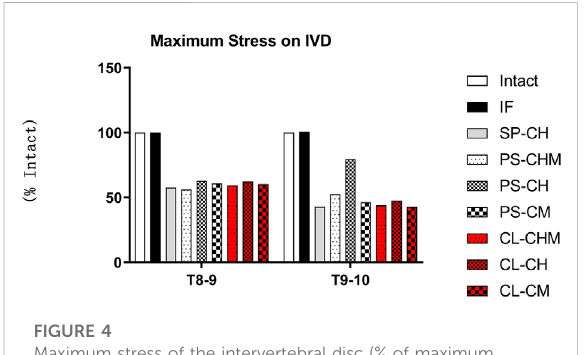
FIGURE 4 Maximum stress of the intervertebral disc (% of maximum stress of the intervertebral disc in model intact), measured at T8 – 9 and T9 – 10 segments for model intact, and IF, SP-CH, PS- CHM, PS-CH, PS-CM, CL-CHM, CL-CH, and CL-CM models.